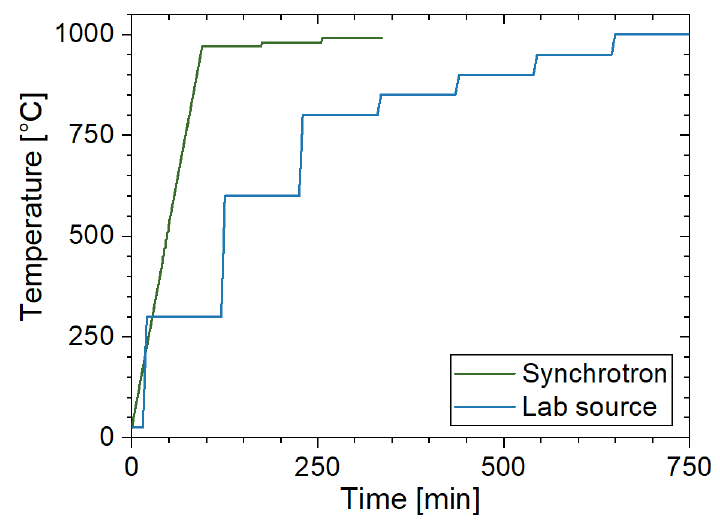
Figure 1. Schematics illustrating the heating process performed during the lab-source and synchrotron X-ray diffraction experiments.